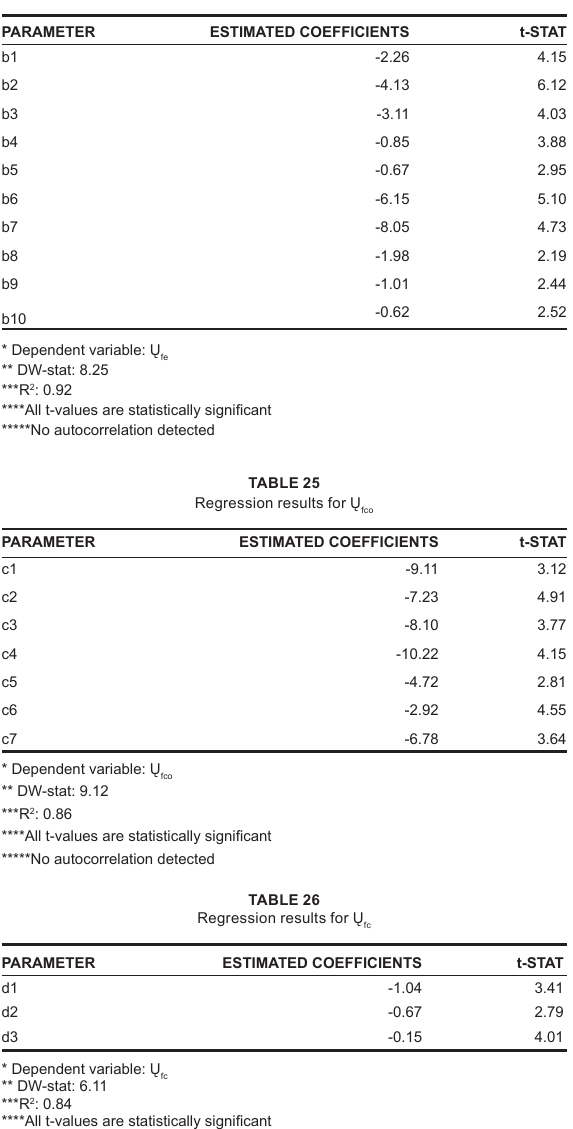
TABLE 24 Regression results for Ų fe